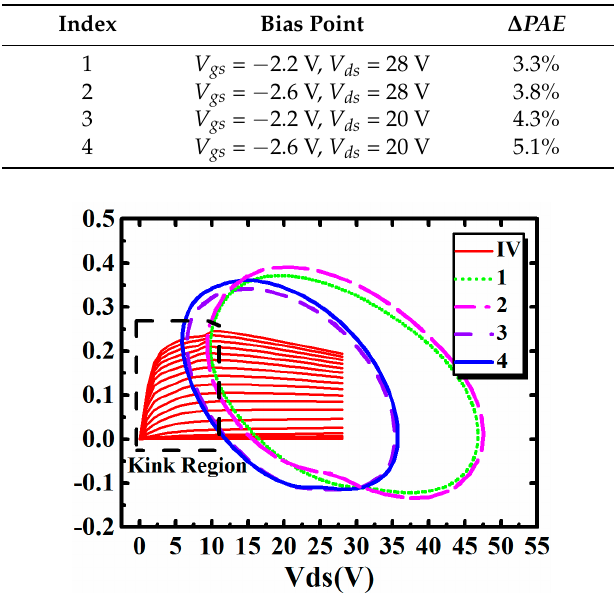
Figure 11. The distribution of AC dynamic load lines at four different bias points.